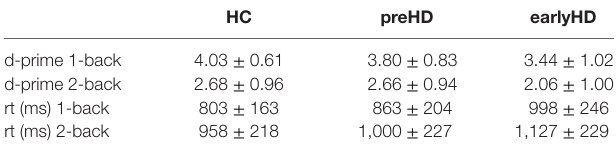
Table 2 | Behavioral results from the working memory task (mean and SD). hc prehD